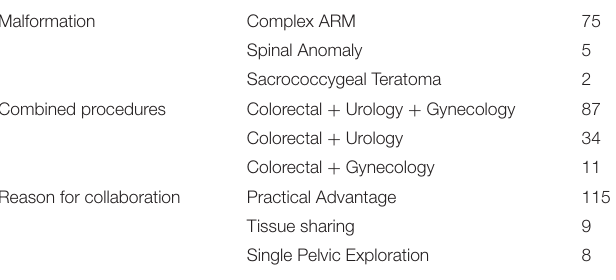
TABLE 1 | Description of the services involved in the combined procedures.